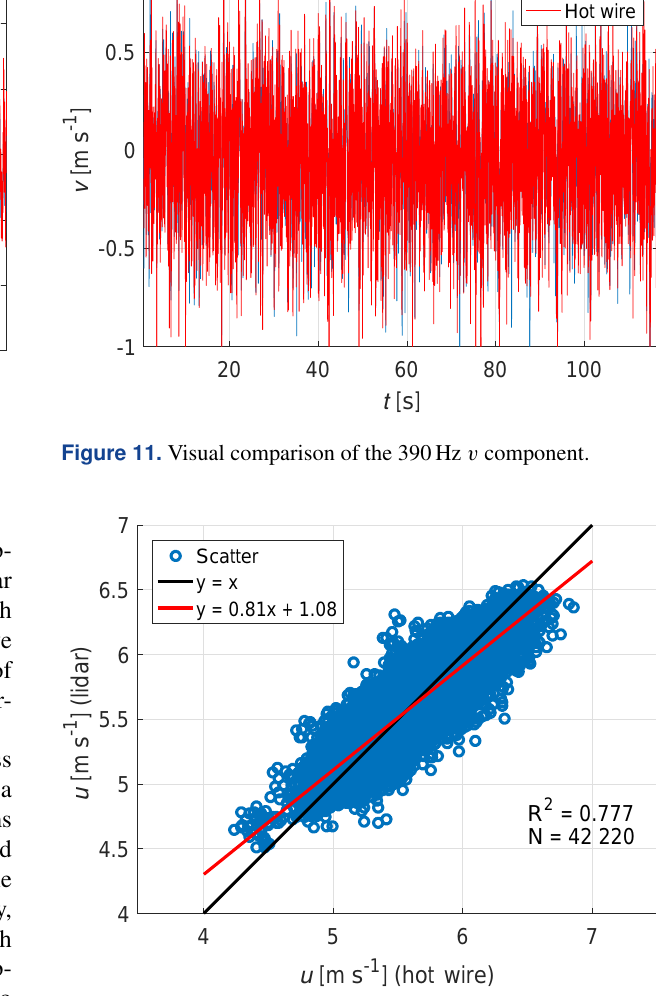
Figure 12. Correlation of the 390Hz u